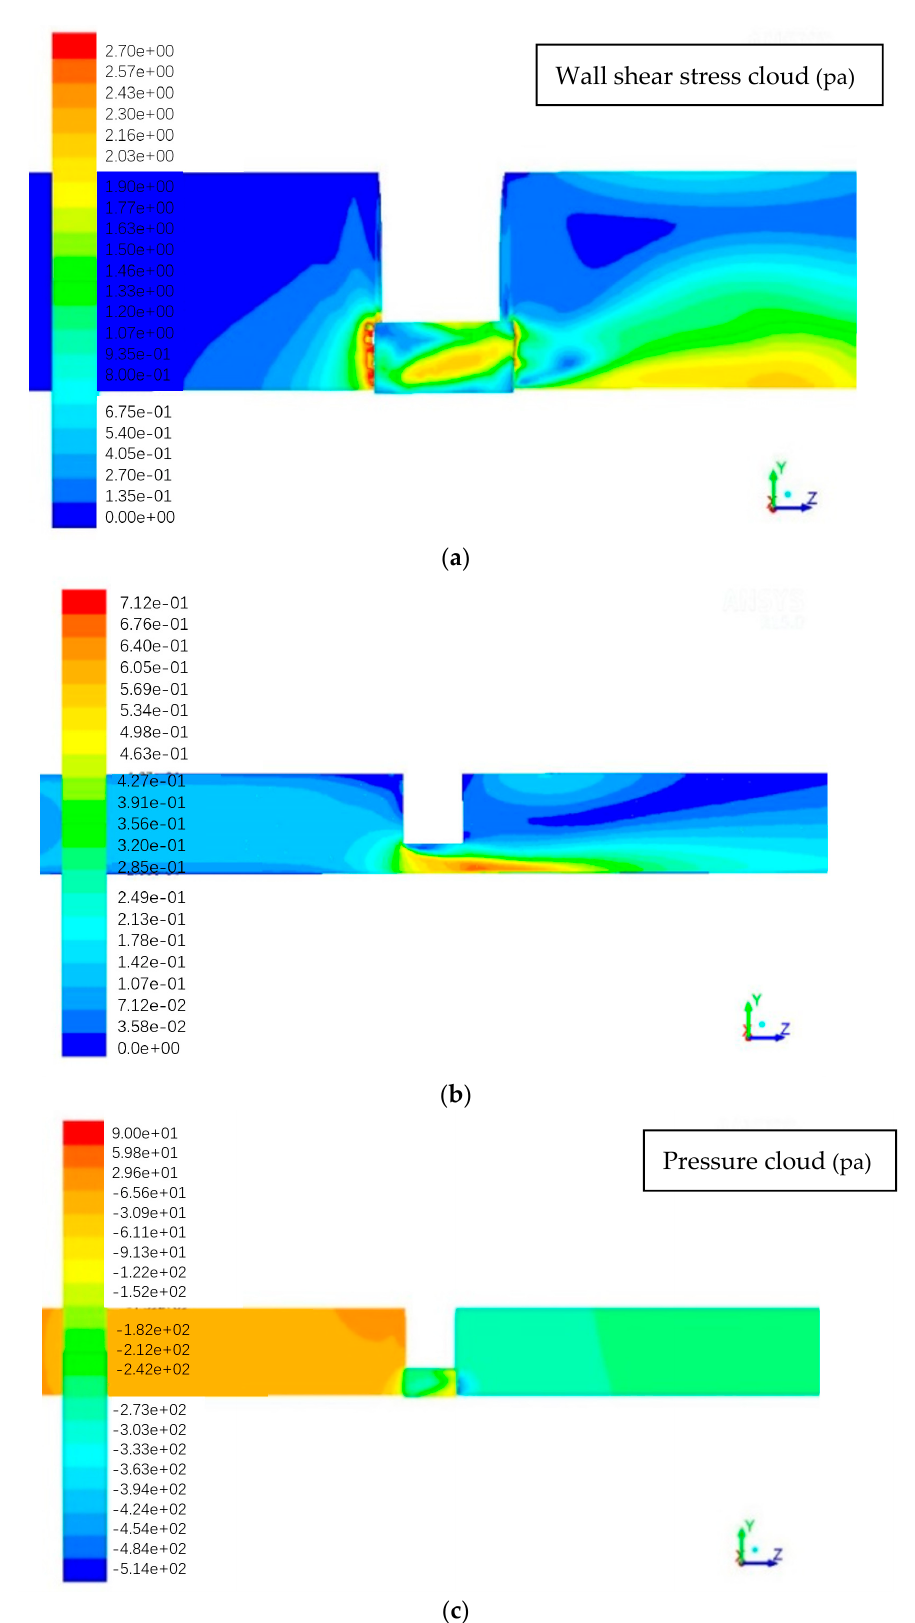
Figure 21. Numerical simulation results for the tee outlet pipe diameter 110 mm, flow rate 0.1 m/s; ( a ) Wall shear stress cloud Figure; ( b ) Velocity cloud; ( c ) Pressure cloud.